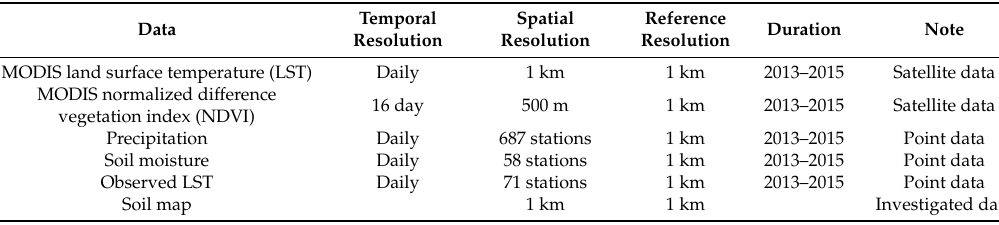
Table 1. Description of data